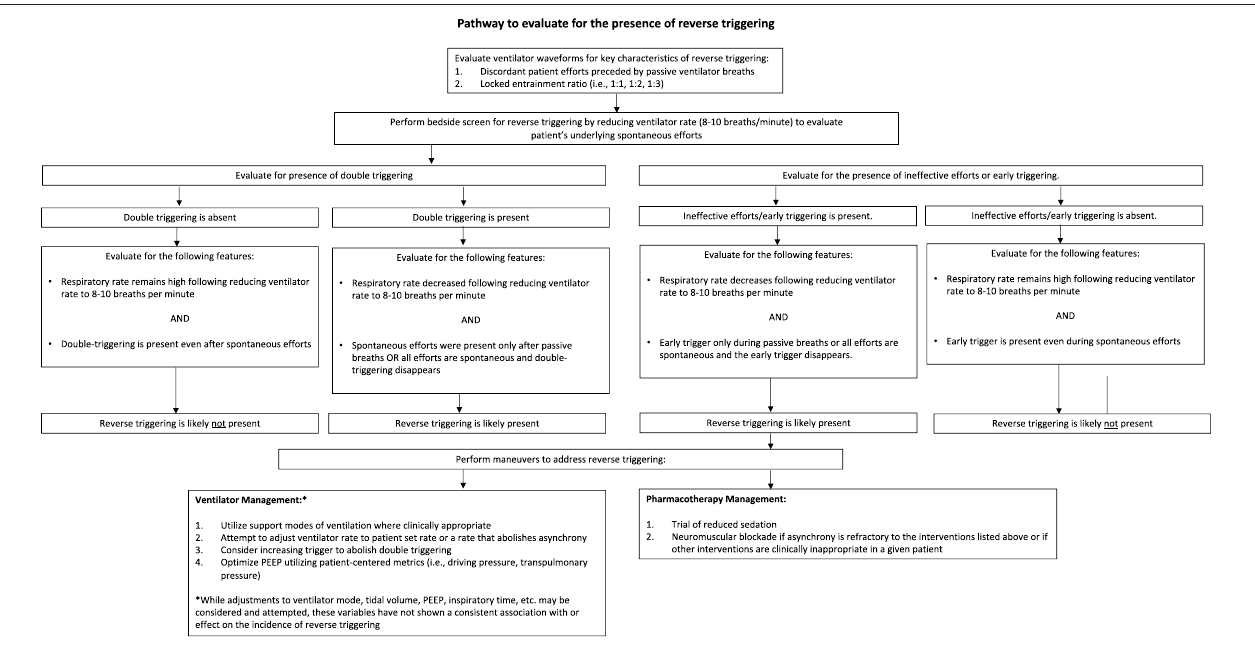
FIGURE 4 | Proposed approach to the patient with ventilator asynchrony and possible reverse triggering.